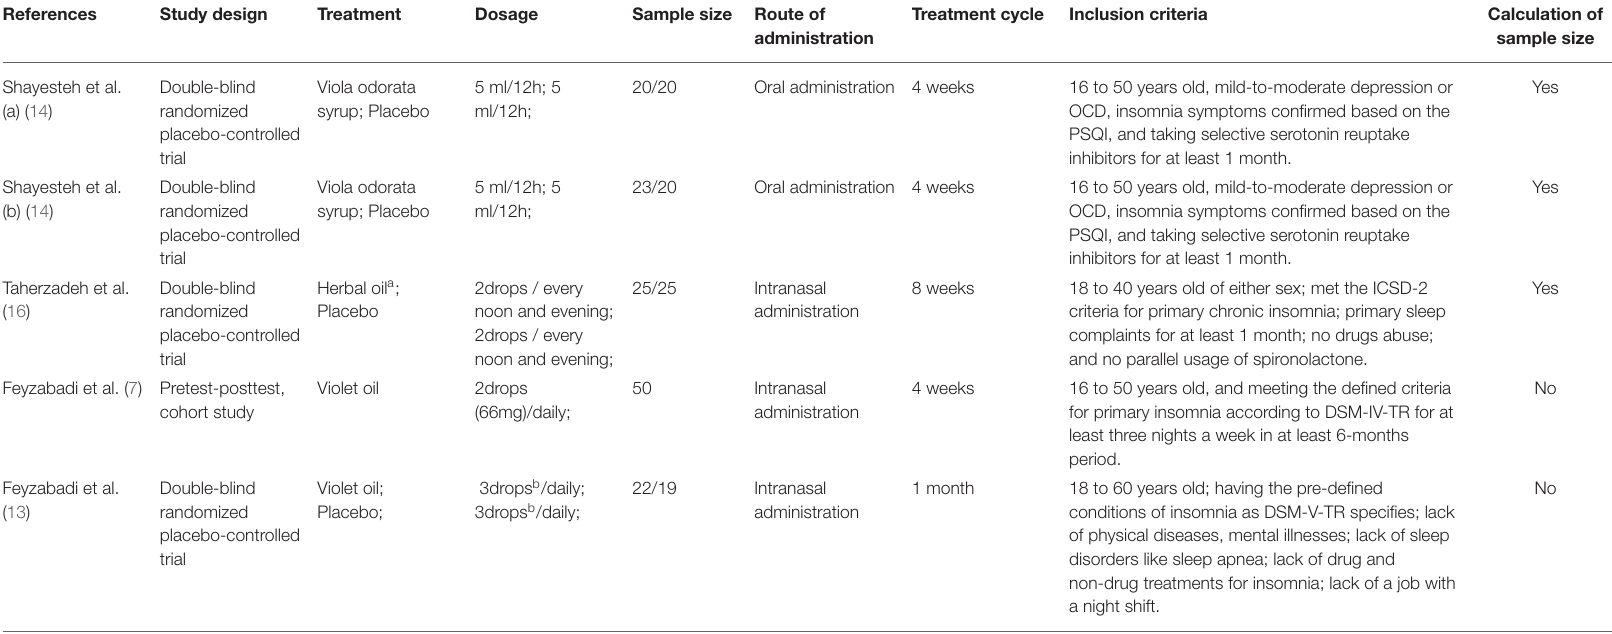
TABLE 2 | The details of individual